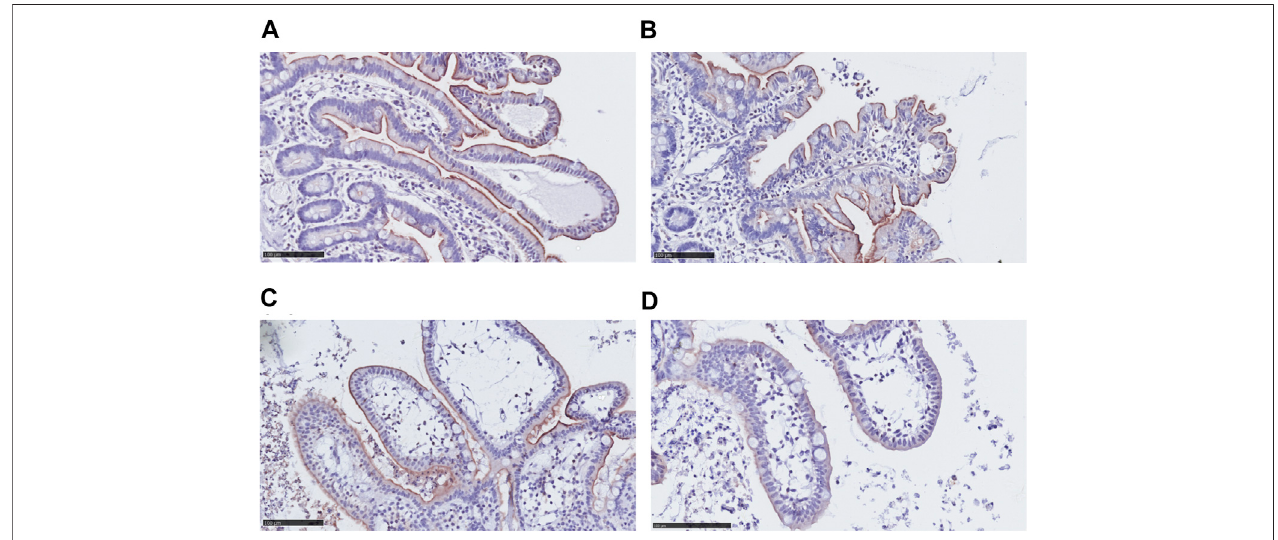
FIGURE 1 | Morphology and ABCB1 expression in non-sliced intestine and hPCISs. Intact brush border epithelium and signi fi cant ABCB1 positivity (brown color) were observed in the non-sliced tissue (A) in fresh hPCISs, time (cid:2) 0 h (B) , after 24 h (C) , and in hPCISs incubated for 48 h (D) . The slides were counterstained with hematoxylin (scale bar (cid:2) 100 µm).